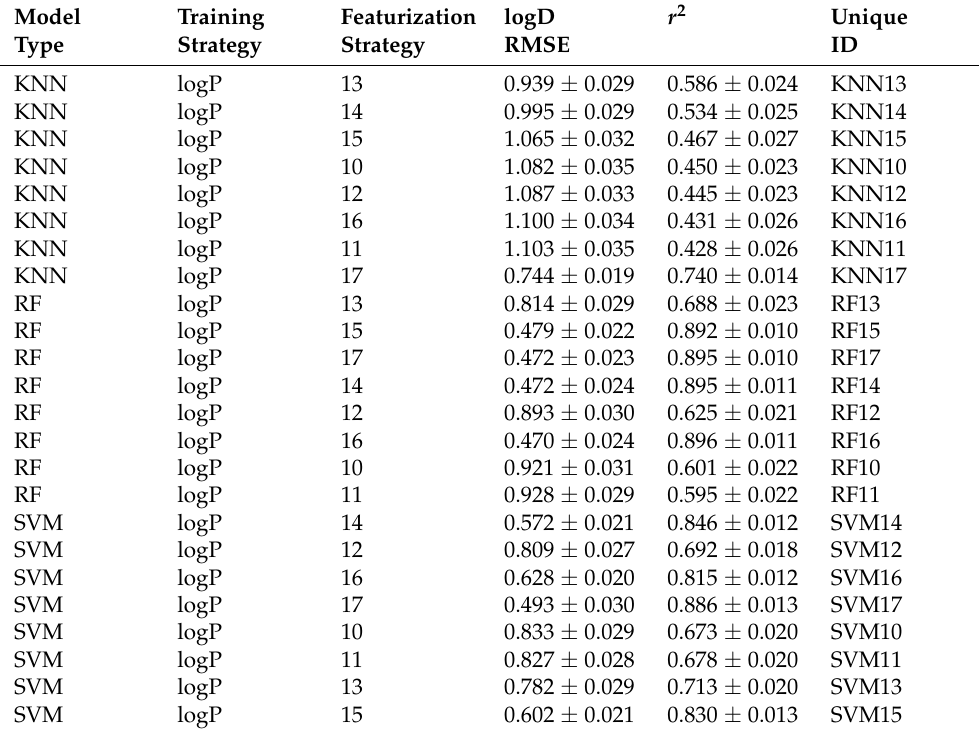
Table A19. Shows the logP RMSE and r 2 results for the non-GNN model types used during this survey. The last column consists of the unique identifier. Training strategy 0 represents a training strategy combining logD, logS, and logP, 1 represents a strategy combining logD and logP, 2 stands for a combination of logD and logS, 3 represents a strategy using logS and logP, 4 represents a strategy using logD, 5 represents a strategy using logS, and 6 represents a strategy using